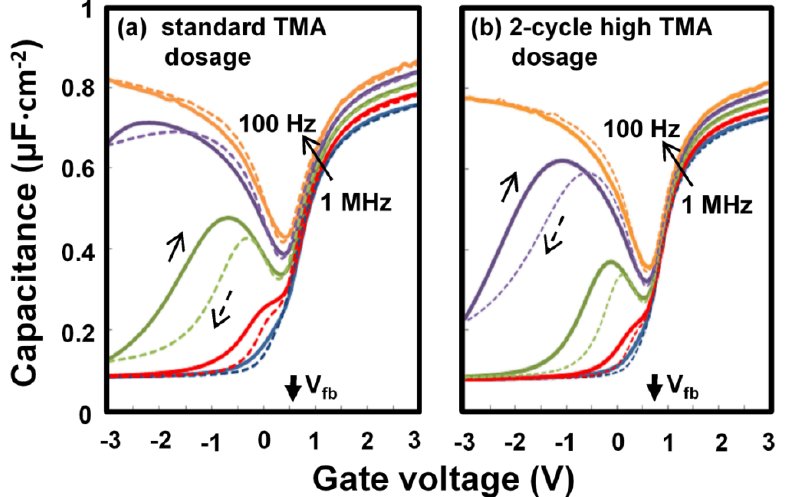
Figure 4. C-V characteristics of Au/Al constant TMA dosage for all 60 cycles, and ( b ) a high TMA dosage for the first 2